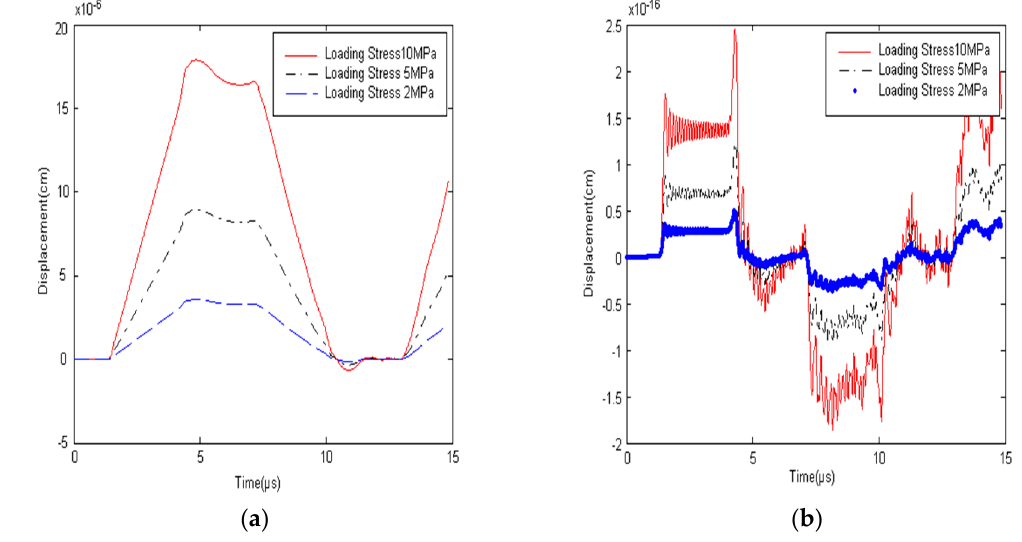
Figure 18. The displacement of a point at the crack tip of phonon field( a ) and phason field( b ).